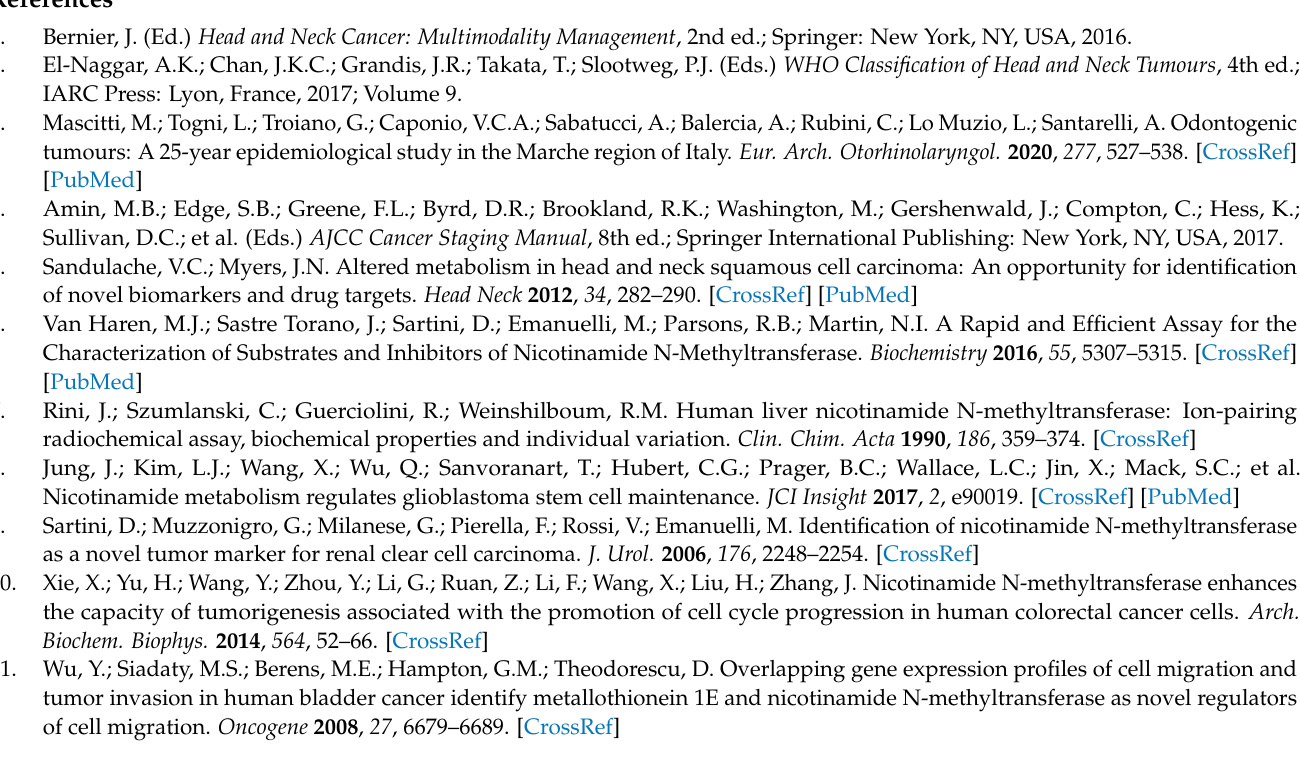
NPC - Association with worse DSS and MeFS. - Overexpression in cell lines; LSCC - Increase in cell proliferation. - Overexpression in tumor samples - Overexpression in N+ ESCC; ESCC - Increase in cells growth, proliferation, and migration; - Increase tumor cell